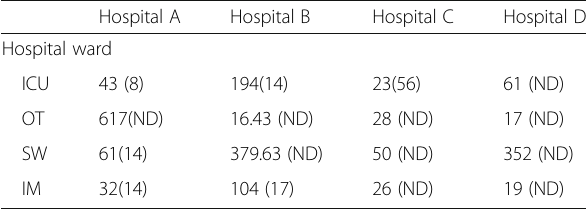
Table 2 Mean concentration (CFU/m 3 ) of airborne bacteria (A. baumannii ) a in different hospital